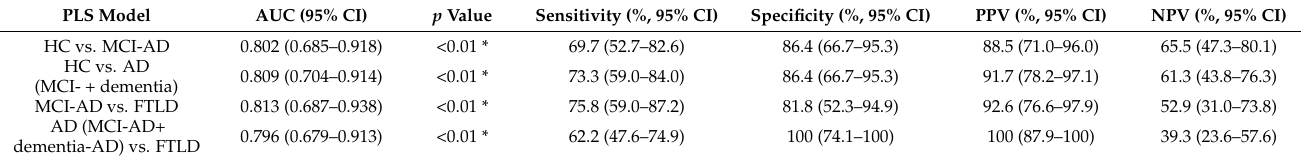
Table 4. Diagnosis indexes for the developed AD prediction models.